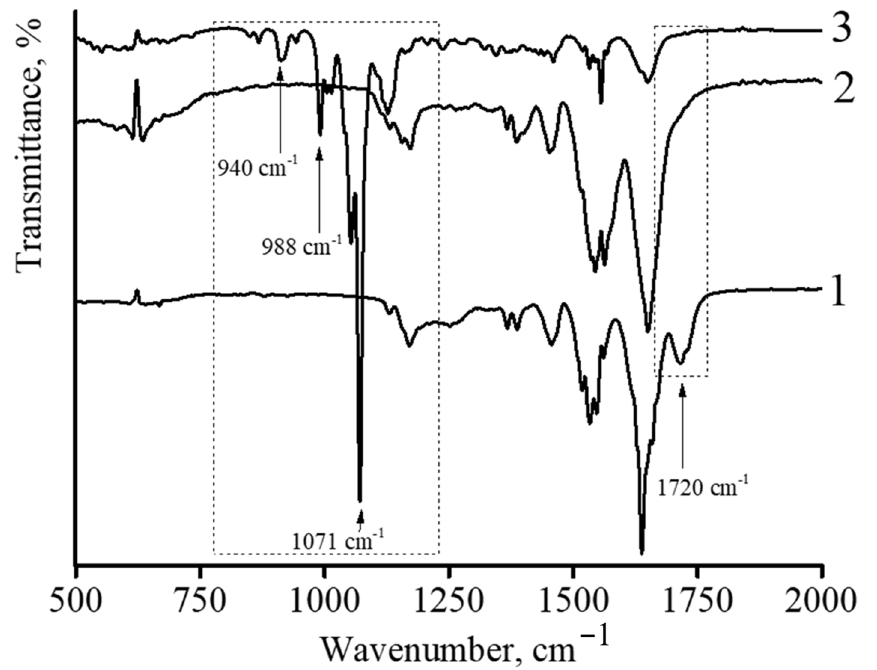
Figure 6. IR spectra of polymer microgel NIPAM ‐РАА (1); nanocomposite NIPAM ‐РАА‐β‐ FeO(OH) (2); triple nanocomposite NIPAM ‐РАА‐β‐ FeO(OH)–DOX, [AC]/[DOX] = 1/1 (3).